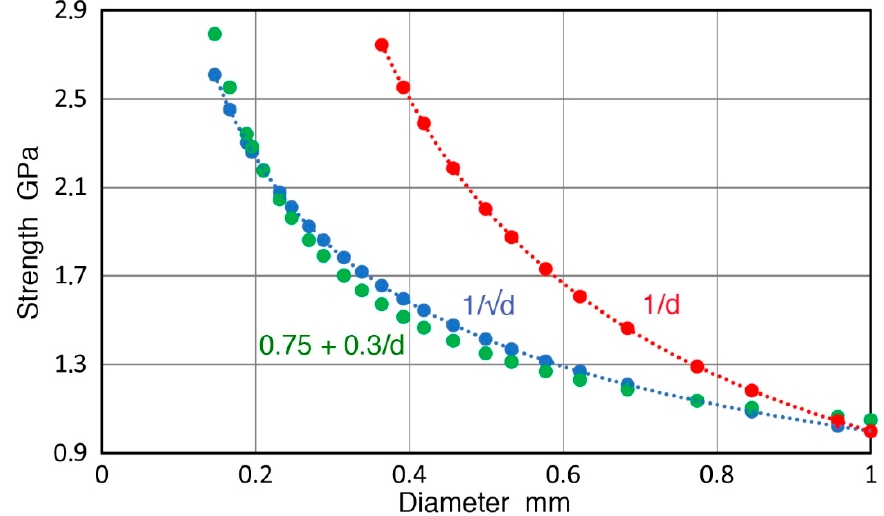
Figure 6. Strength versus diameter using three different representations.